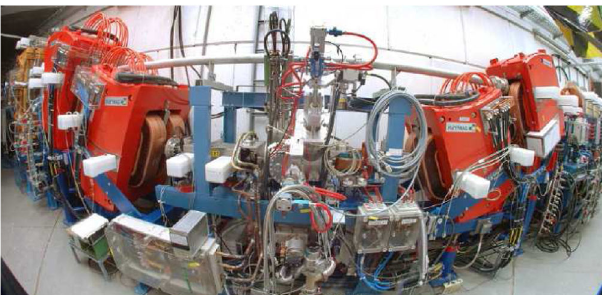
FIG. 8. Fish eye photograph of the foil charge state stripper at the GSI UNILAC including the four bend analyzing chicane. The beam enters from the left.